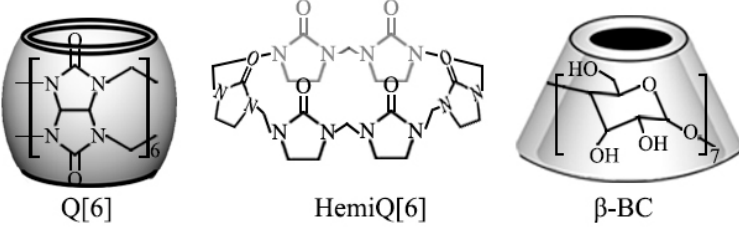
Figure 7. Molecular structures of Q[6], HQ[6], and BC.